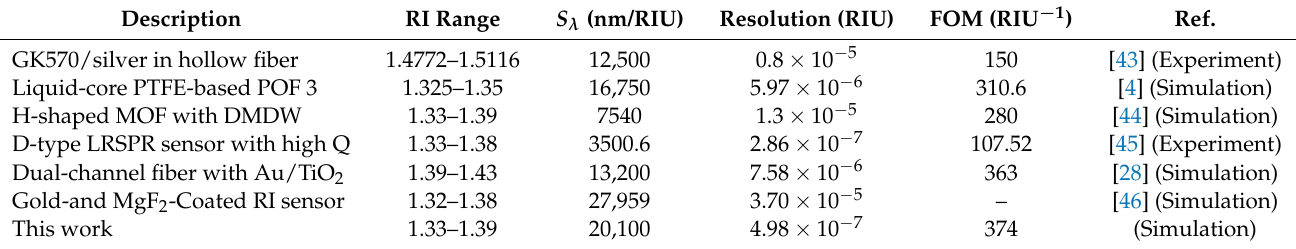
Table 1. Comparison of the performance of the proposed sensor with recently reported LRSPR